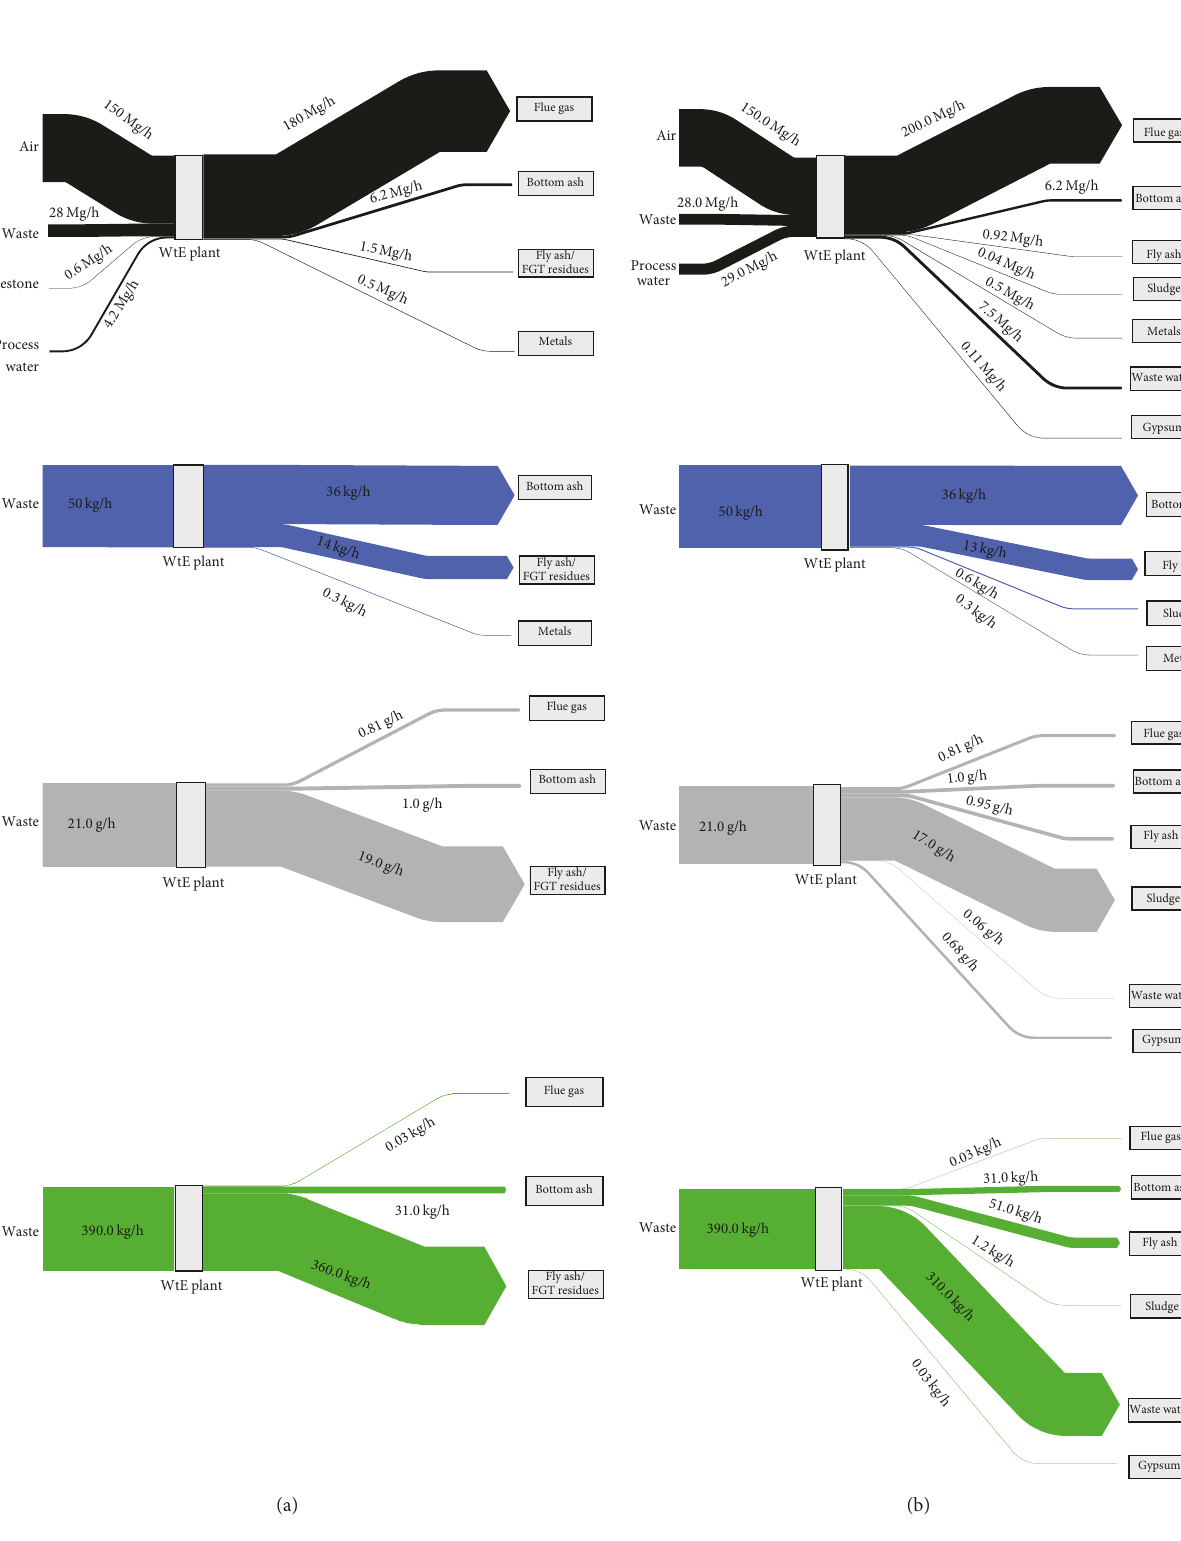
Figure 6: Material flow analysis for the mass flow (black), zinc (blue), mercury (gray), and chlorine (green) for heat-conducted (b) and power-conducted (a) WtE